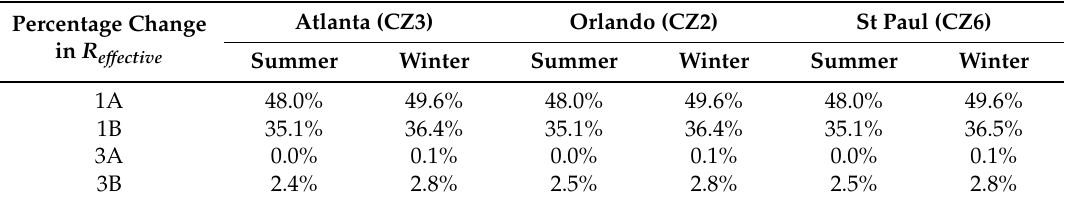
Table 7. Percentage R effective changes for all 4 Assemblies under different design conditions.